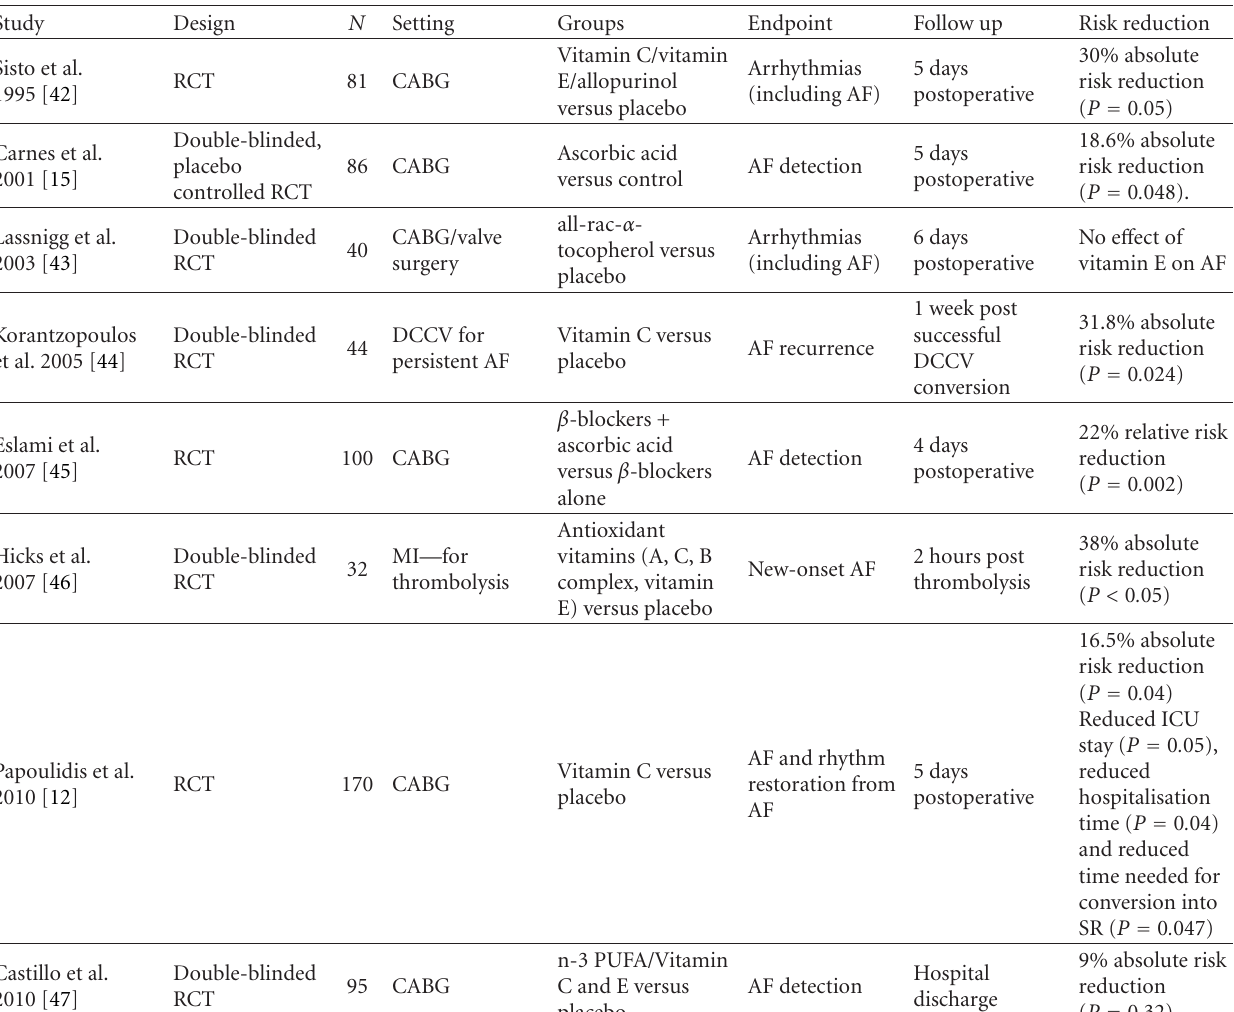
Table 2: Summary of clinical evidence for the use of antioxidant vitamins in AF